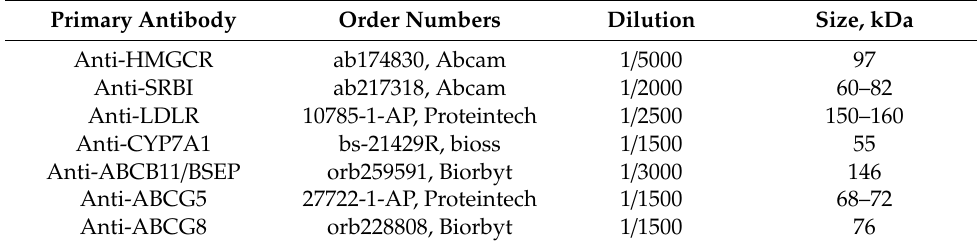
Table 2. The primary antibody of Western